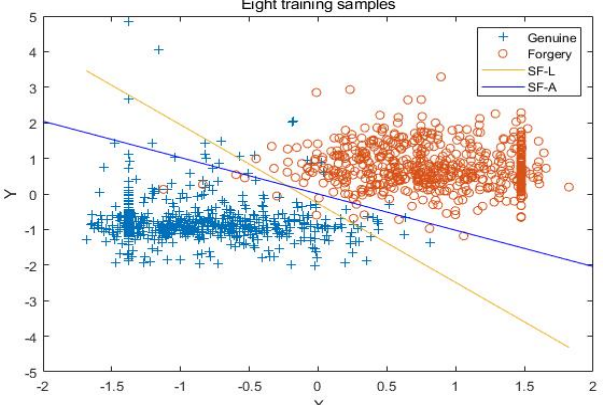
Figure 5. Sample distribution when using eight training samples.